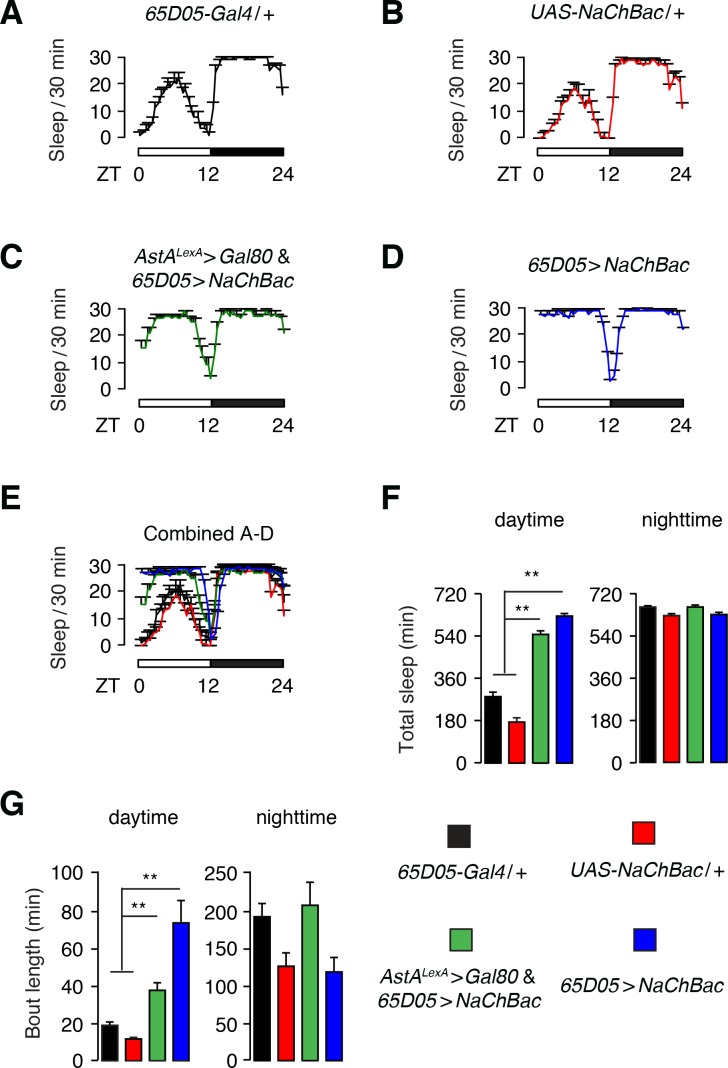
Sleep promoting effects resulting from hyperactivation of a subset of 65D05-Gal4 neurons that are not labeled by the AstAlexA reporter.(A—E) Sleep profiles of the indicated flies during a single day (ZT0—ZT12) and night (ZT12—ZT24). The amount of sleep is plotted per 30 min bins. (F) Quantification of total daytime and nighttime sleep exhibited by the indicated flies (see color coding of the genotypes in A—D). (G) Quantification of daytime and nighttime sleep-bout length of the indicated flies (see color coding of the genotypes in A—D). Error bars, SEMs. **p<0.01, one way ANOVA with Dunnett’s test. n = 32 for 65D05-Gal4/+, n = 32 for UAS-NaChBac/+, n = 28 for AstALexA >Gal80 and 65D05 > NaChBac, and n = 23 for 65D05-Gal4 > NaChBac.